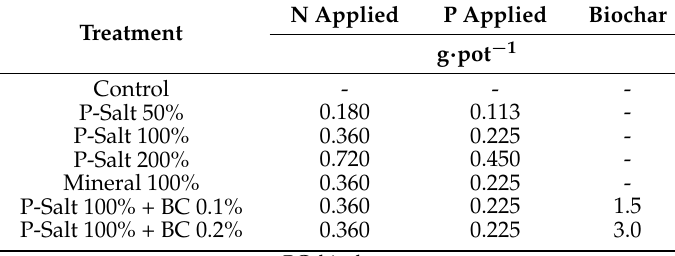
Table 5. Overview of all treatments and corresponding N and P application